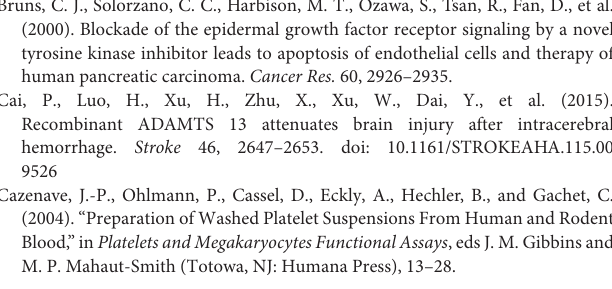
FIGURE S1 | (A) Thrombocytopenia was achieved successfully by injection of an anti-mouse GPIb α antibody. Representative density plots of platelets defined by CD61-positivity and sideward light scatter (SSC) characteristics. CD61-FITC was used to stain platelets, expressed as mean fluorescence intensity values (MFI; relative linear units scaled from 0 to 10 4 ), platelet counts expressed as percentage relative to control (100%) were measured with flow cytometry. n = 8 per group. Unpaired 2-tailed Student t -test. (B) Representative confocal microscopy images and quantitative analysis of fibrin deposits in microvessels from mice treated with vehicle, tPA, tPA + resting platelets, or tPA + tyrode buffer 24 h after cerebral ischemia. Bar = 60 µ m. n = 5 per group. Values are mean ± SD. ∗ P <